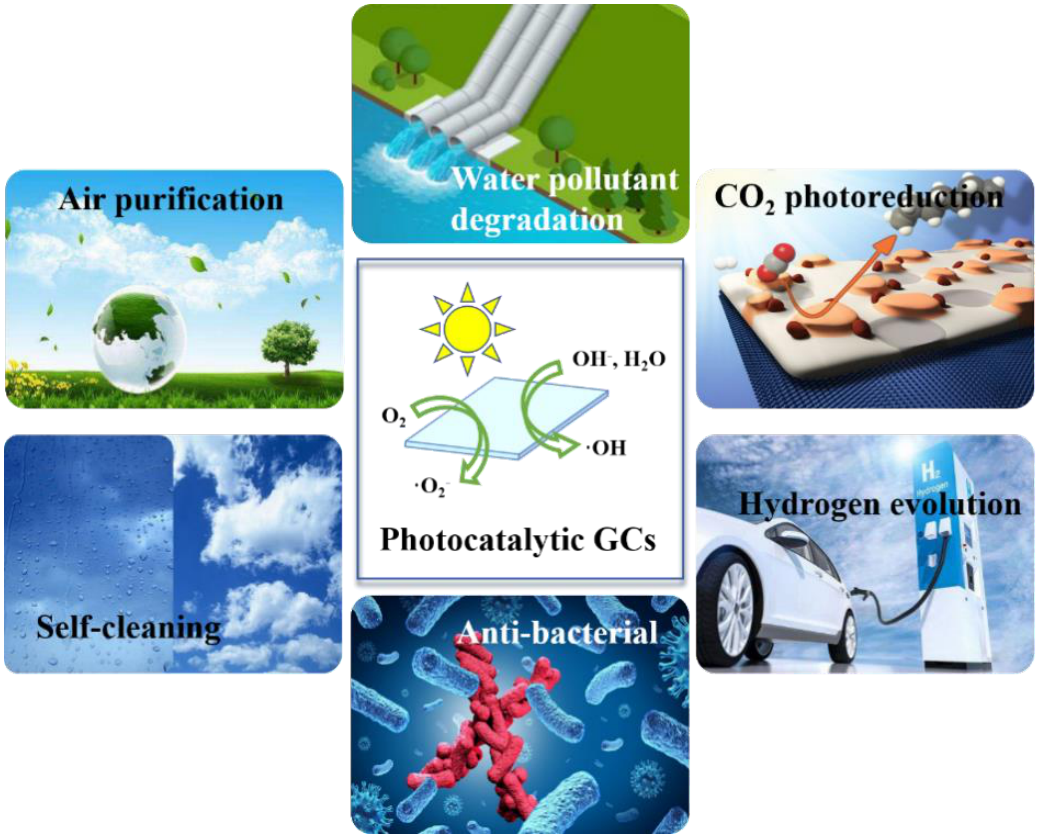
Figure 3. Potential environmental applications of PGCs.